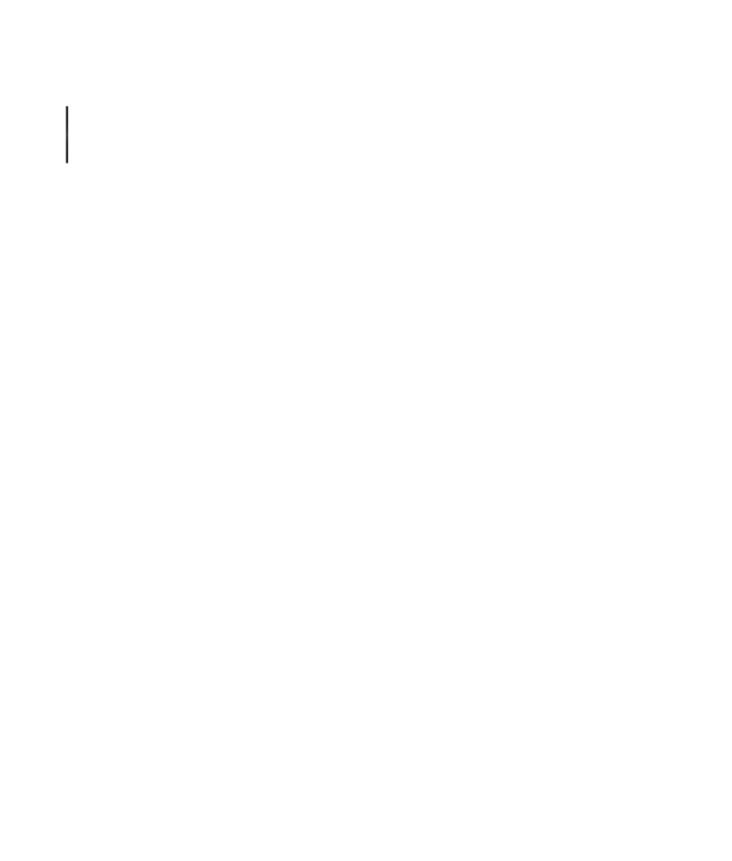
TGF-β upregulates MMP-9 secretion in LM3 tumor cells. (A) MMP-9 mRNA expression in LM3 cells treated with 2 ng/ml TGF-β1, by RT-PCR. β-actin (Actb) was used as loading control. (B) MMP-9 activity in LM3 cells treated with or without 2 ng/ml TGF-β1, by gelatin zymography of 24 h conditioned medium. Control EGFP-expressing LM3 cells, as well as LM3 cells expressing dominant-negative receptors TβRI-K232R or TβRII-K277R, were also examined. (C) Gelatinase activity in LM3 cells in response to TGF-β1, in the presence of the p38MAPK inhibitor SB202190 (10 μM) or the MEK inhibitor PD98059 (5 μM). In both (B) and (C), data are expressed as the mean ± SD of triplicates, and are representative of three independent experiments. (*p<0.05 vs. the untreated cells; #p<0.05 vs. the TGF-β-treated cells).